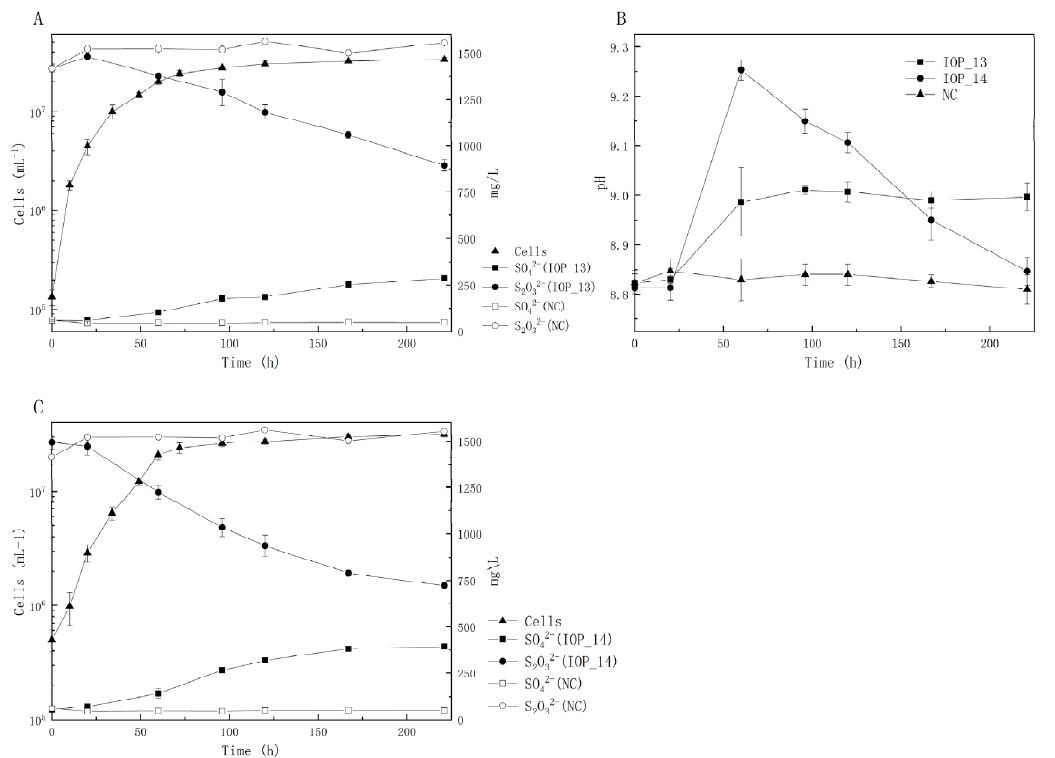
Figure 4. The growth of isolates in autotrophic sulfur-containing media. ( A ) the growth curve of Pseudomonas sp. IOP 13, ( B ) the growth curve of Halomonas sp. IOP_14, and ( C ) the pH change in cultures of strain IOP_13 and strain IOP_14.